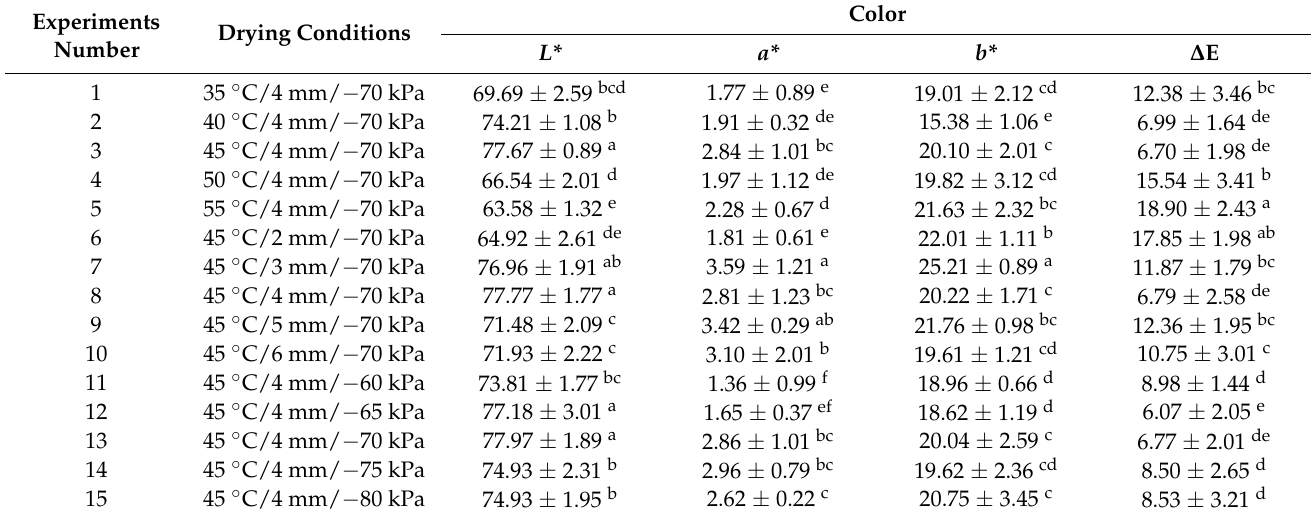
Table 2. Color of Angelica sinensis dried before and after microwave vacuum